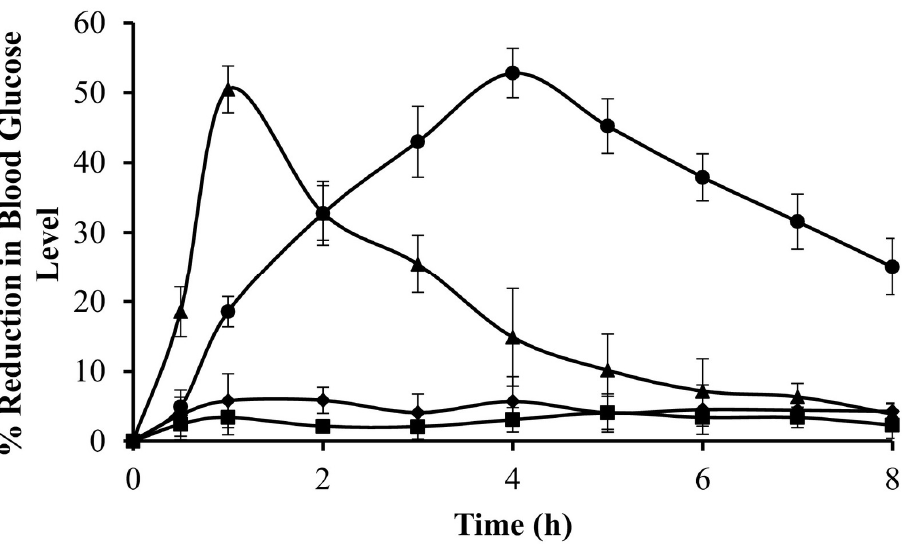
Figure 13. Preclinical efficacy of XGD6 hydrogel particles [CMXG + CEXG acetylated hydrogel containing repaglinide]. Key: diabetic control ( ◆ ), negative control ( ■ ), pure repaglinide suspension ( ▴ ) and XGD6 formulation ( ● ). Reprinted from [122] with permission.